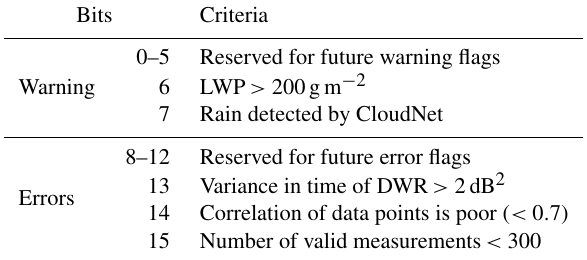
Table 4. Quality flags included in the data Level 2 product (bit coded in a 16-bit integer value). The flags indicate the reliability of the data and in relation to the quality of the relative offset esti- mate for X-Ka and W–Ka band reflectivities. Note that offsets are not calculated when the number of reflectivity pairs is below 300. Bits Criteria 0–5 Reserved for future warning flags Warning Rain detected by CloudNet